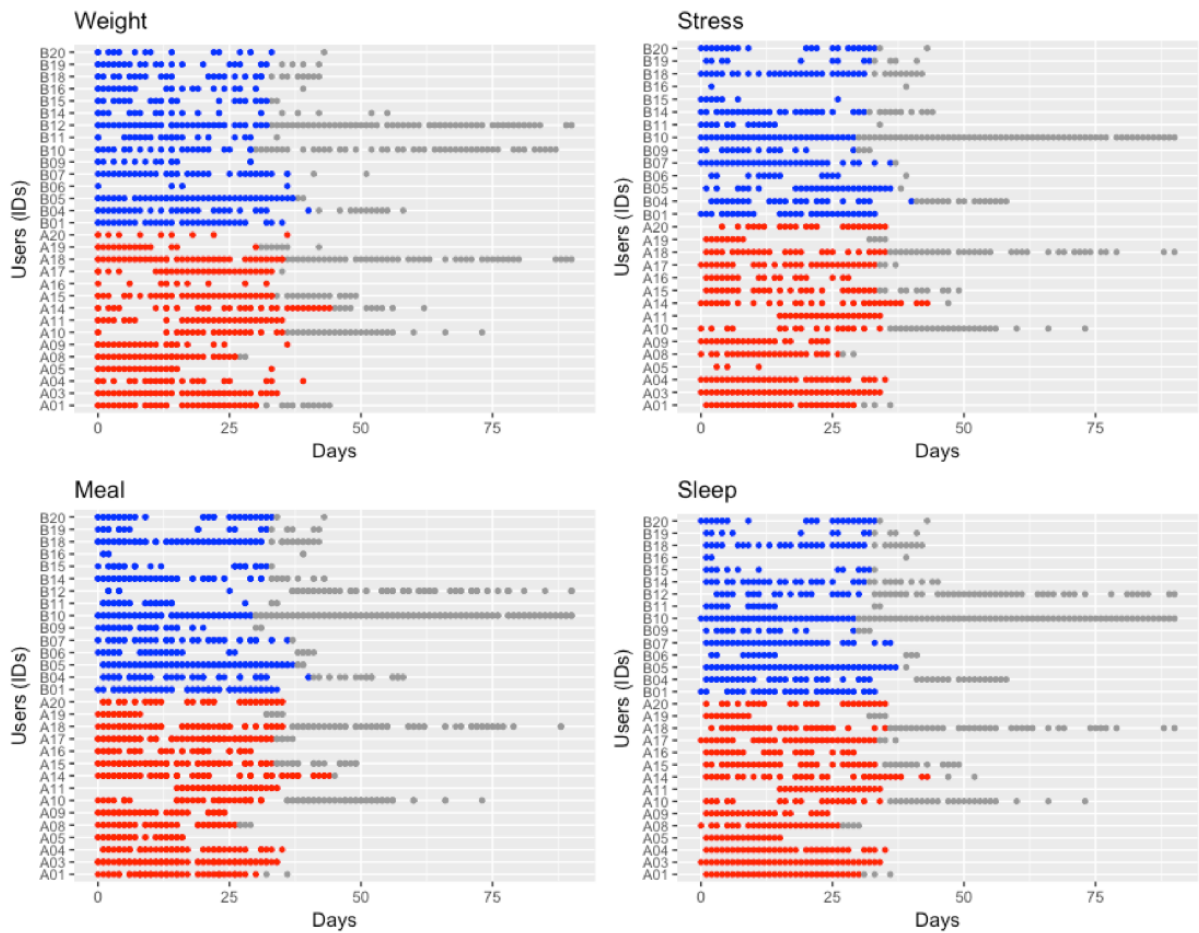
Figure 7. The number of recorded lifelog data for weight, stress, meal, and sleep logs (red: recorded days by app plus wearable users; blue: recorded days by app-only users; and gray: maintain period days without